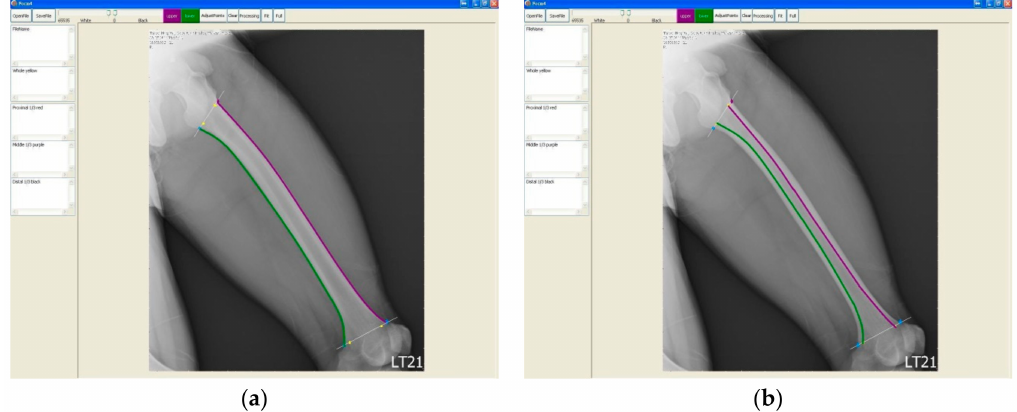
Figure 4. The marked (drawn) outline of cortical border ( a ) and the marked (drawn) outline of medullary canal ( b ).